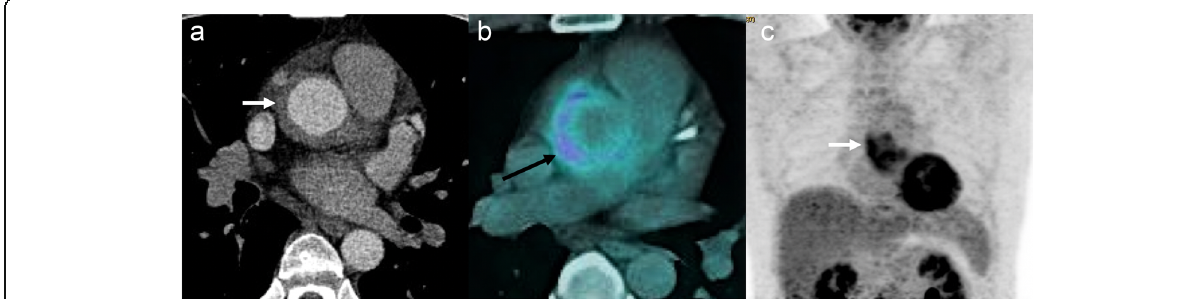
Fig. 11 A 47-year-old male with atypical chest pain. Axial CTA image ( a ) shows circumferential wall thickening (arrow) of the ascending aorta. Axial fused and coronal maximum intensity projection (MIP) F-18 FDG PET-CT images ( b and c ) shows increased FDG uptake in aortic wall (arrow) consistent with active vasculitis (temporal artery biopsy showed giant cell arteritis)